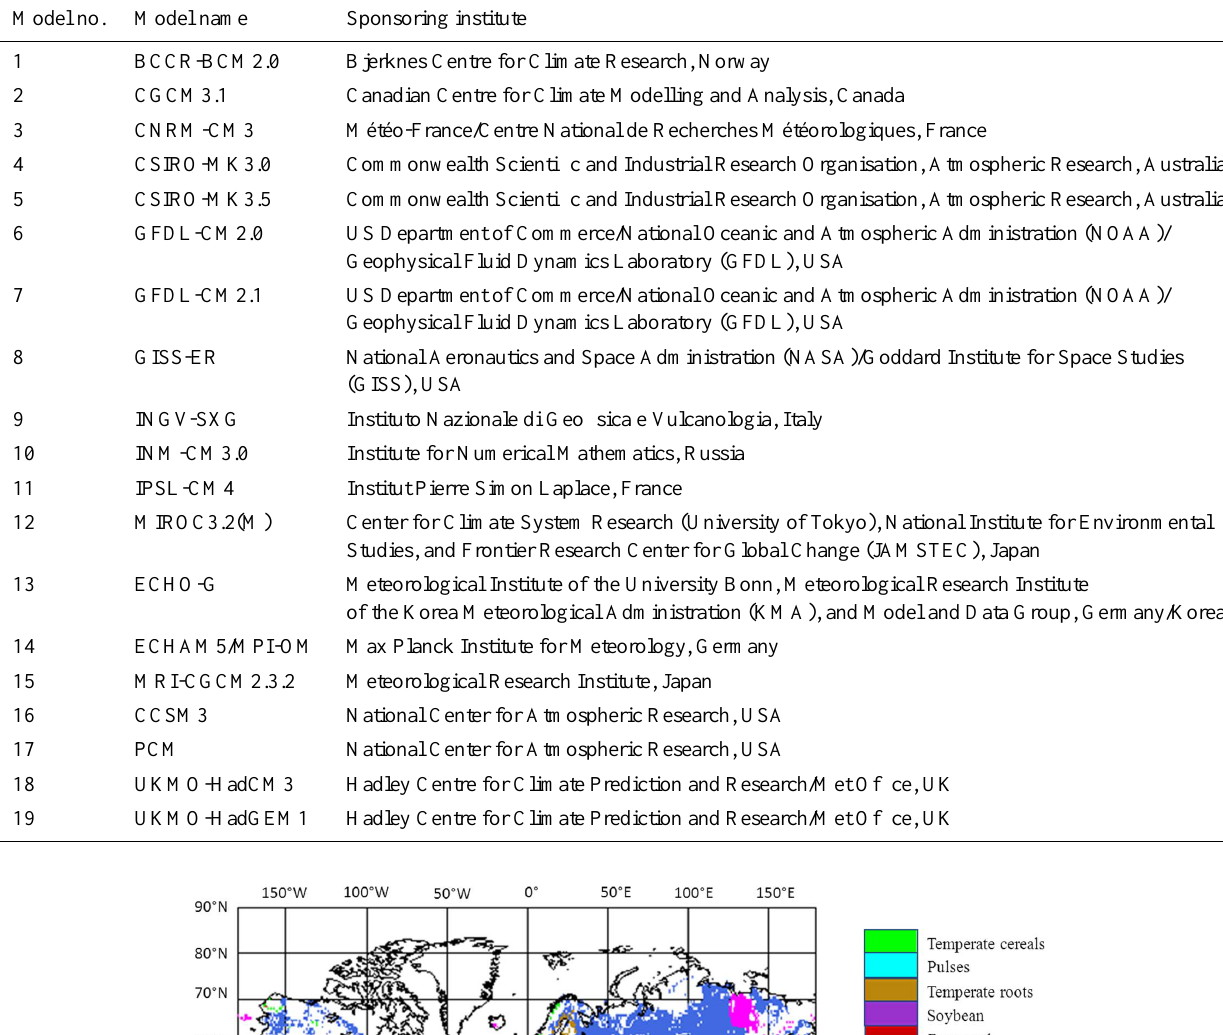
Table 1. The following is a list of GCMs and the corresponding sponsoring institutes whose climate projections were used in this study. Model no.